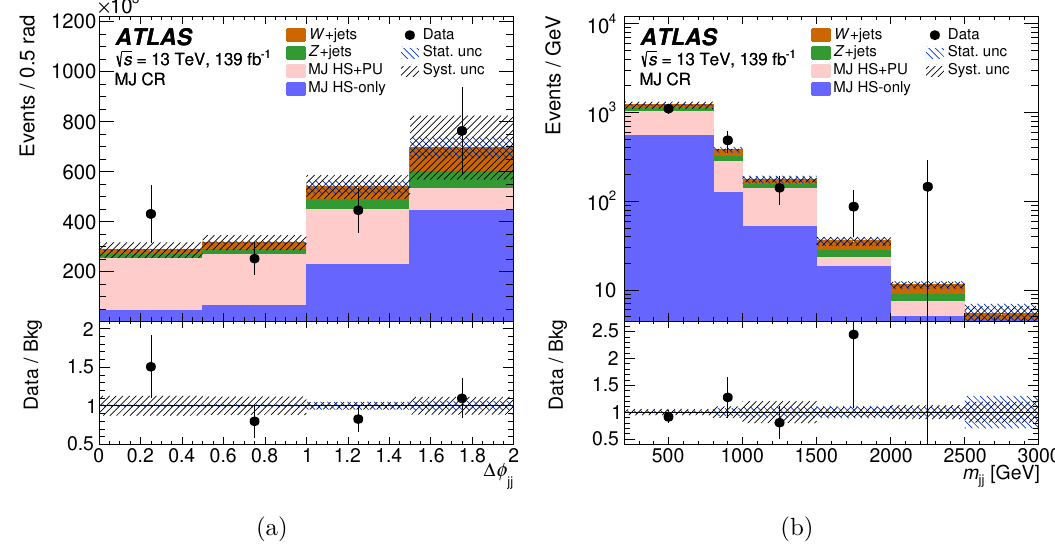
Figure 7. Distributions of (a) ∆ φ jj and (b) m jj are shown in the MJ CR. The shapes of the multijet background components (HS-only and PU+HS) are estimated by the R+S technique using simulated events as input. The components are normalised using a fit to the observed ∆ φ The hatched bands indicate the statistical and the systematic uncertainties